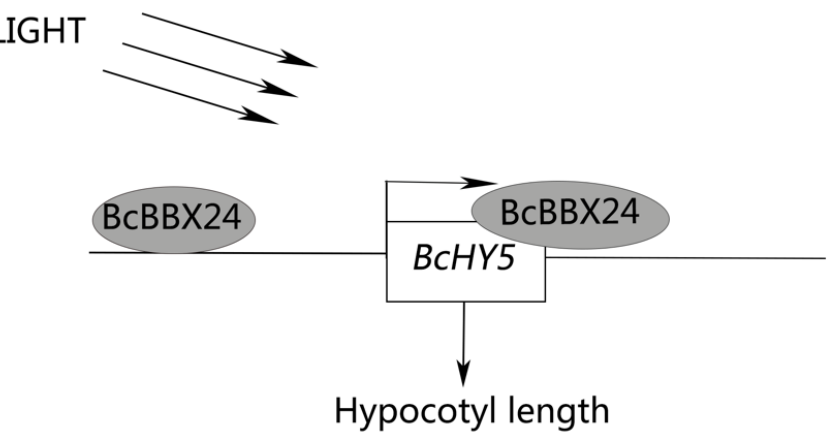
Figure 7. The pattern of BcBBX24 and BcHY5 co-regulating the photomorphogenesis of NHCC. Supplementary Materials: The following supporting information can be downloaded at: www.mdpi.com/xxx/s1; Table S1: Primers were used in this study. Table S2: Proteins sequences of HY5 . Figure S1: The expression of BcHY5 without any treatment.